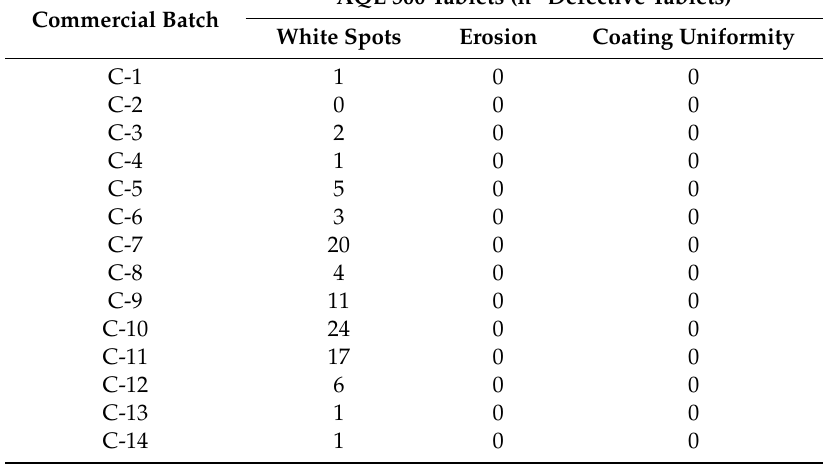
Table 7. Results of the quality control of the post-optimization batches elaborated and released to the